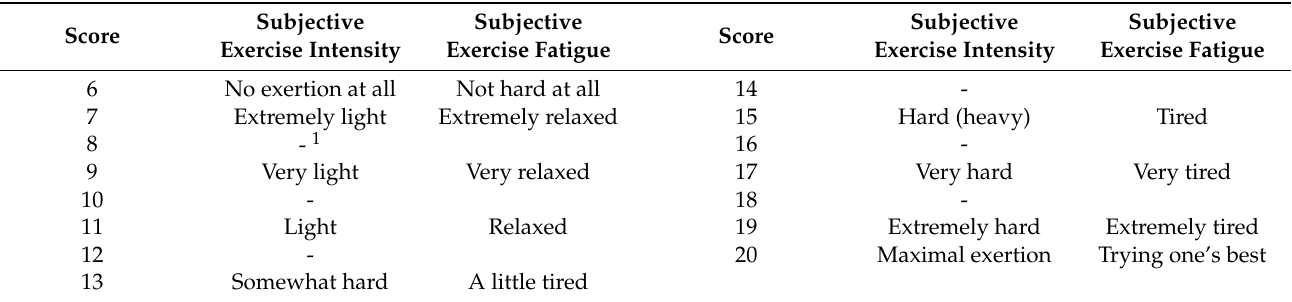
Table 3. Borg’s scale for rating of perceived